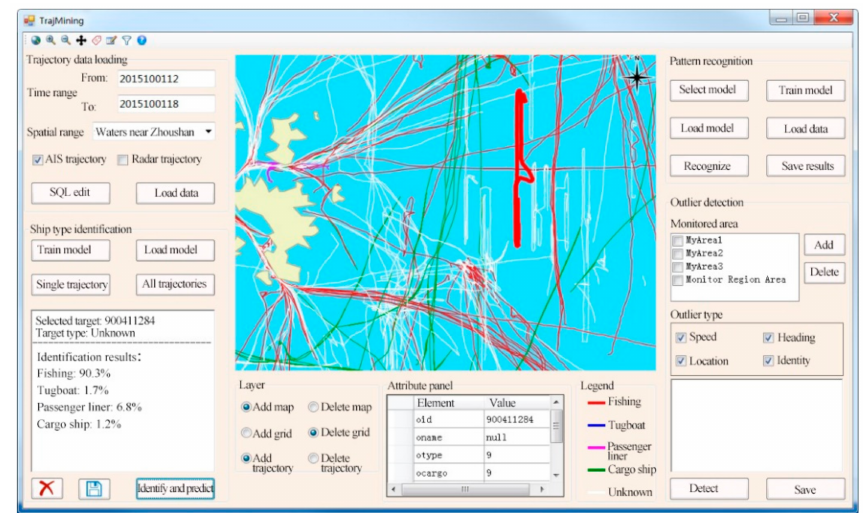
Figure 17. STDMAS unknown ship identification